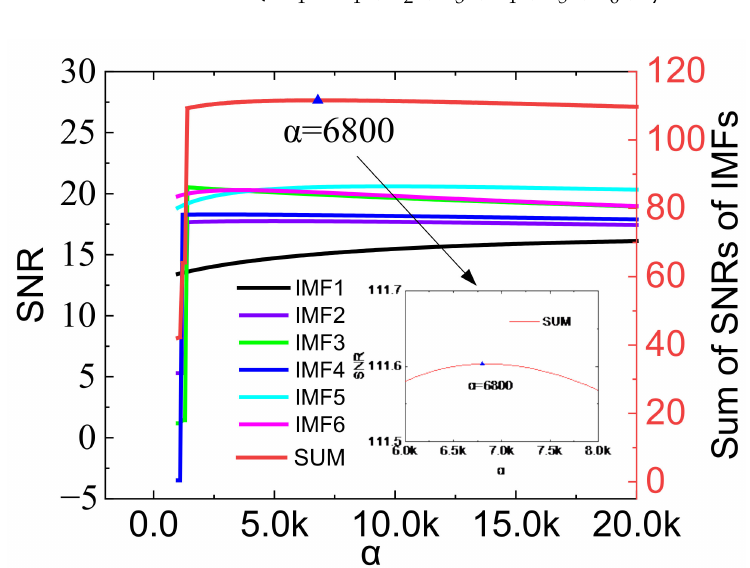
Figure 4. The effect of α on the decomposition